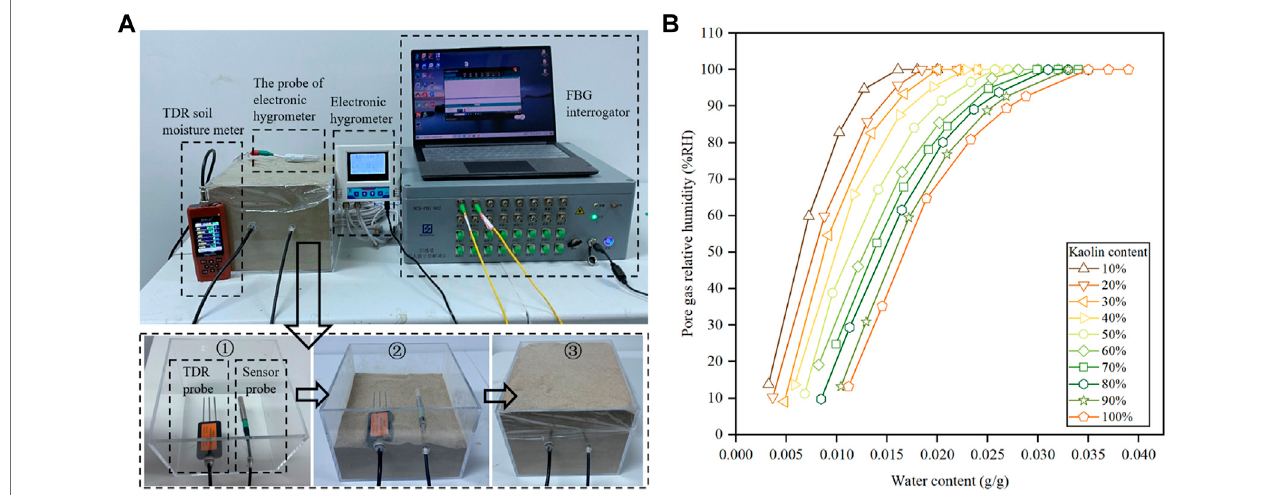
FIGURE 13 | Test device and results of PI-FBG humidity sensor used in the unsaturated soil. (A) Test device. (B) Relationships between pore gas humidity and water content of ten sand-kaolin mixtures (Guo et al., 2021b).